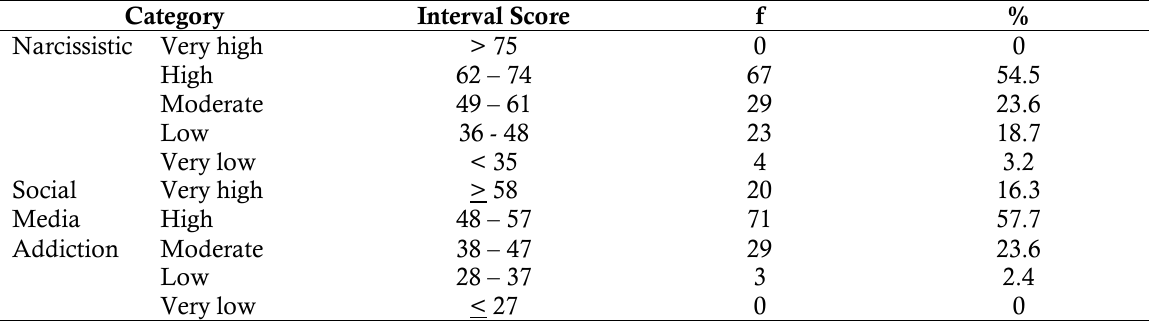
Table 4. Results of Narcissistic Categorization and Social Media Addiction